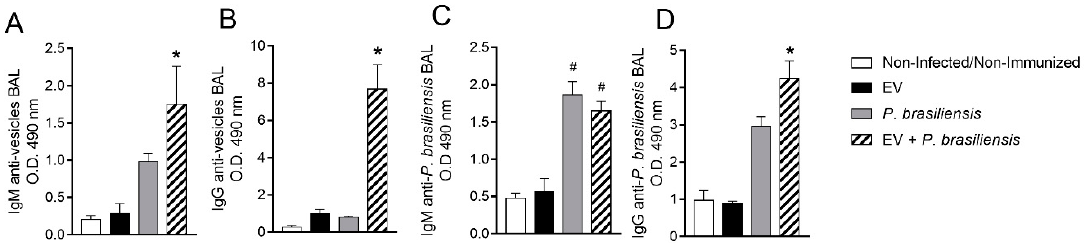
Figure 5. Immunization with EVs from P. brasiliensis induces augmentation of IgG against extracellular vesicles and P. brasiliensis yeast cell protein on day 7 post-infection. IgM anti-EV-derived protein ( A ). IgG anti-EV-derived protein ( B ). IgM anti- P. brasiliensis ( C ). IgG anti- P. brasiliensis ( D ). * p ≤ 0.05 compared to non-infected/non-immunized, EV and P. brasiliensis groups. # p ≤ 0.05 compared to non-infected/non-immunized and EV groups. Non-infected/non-immunized (control). Immunization for 42 days with two doses of 1000 ng of EV protein with adjuvant (boost dose, without adjuvant, given 14 days after the first dose). n = 6 animals per group. Data represents one